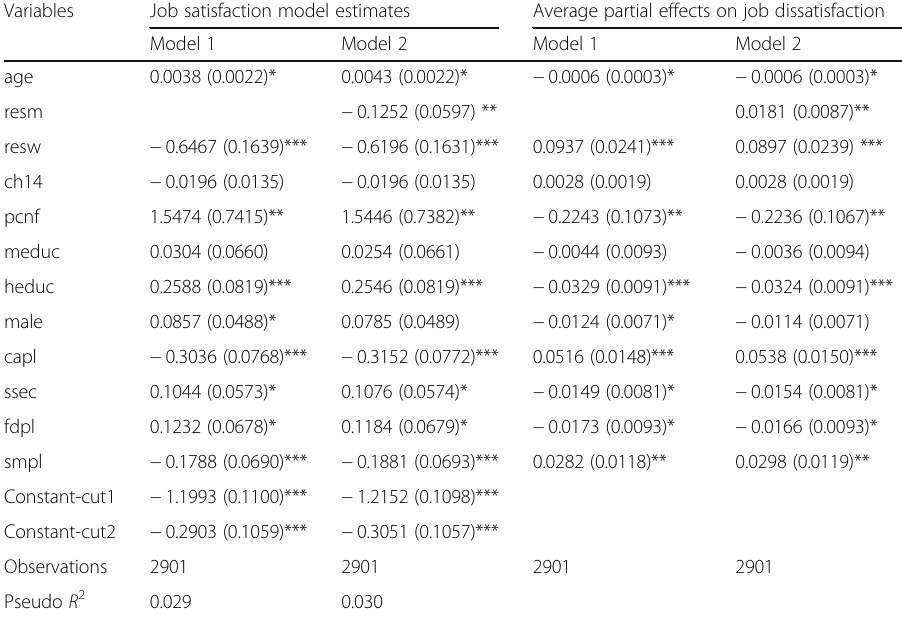
Table 3 Ordered probit model: estimates of job satisfaction and average partial effects on job dissatisfaction, ages of 15 –